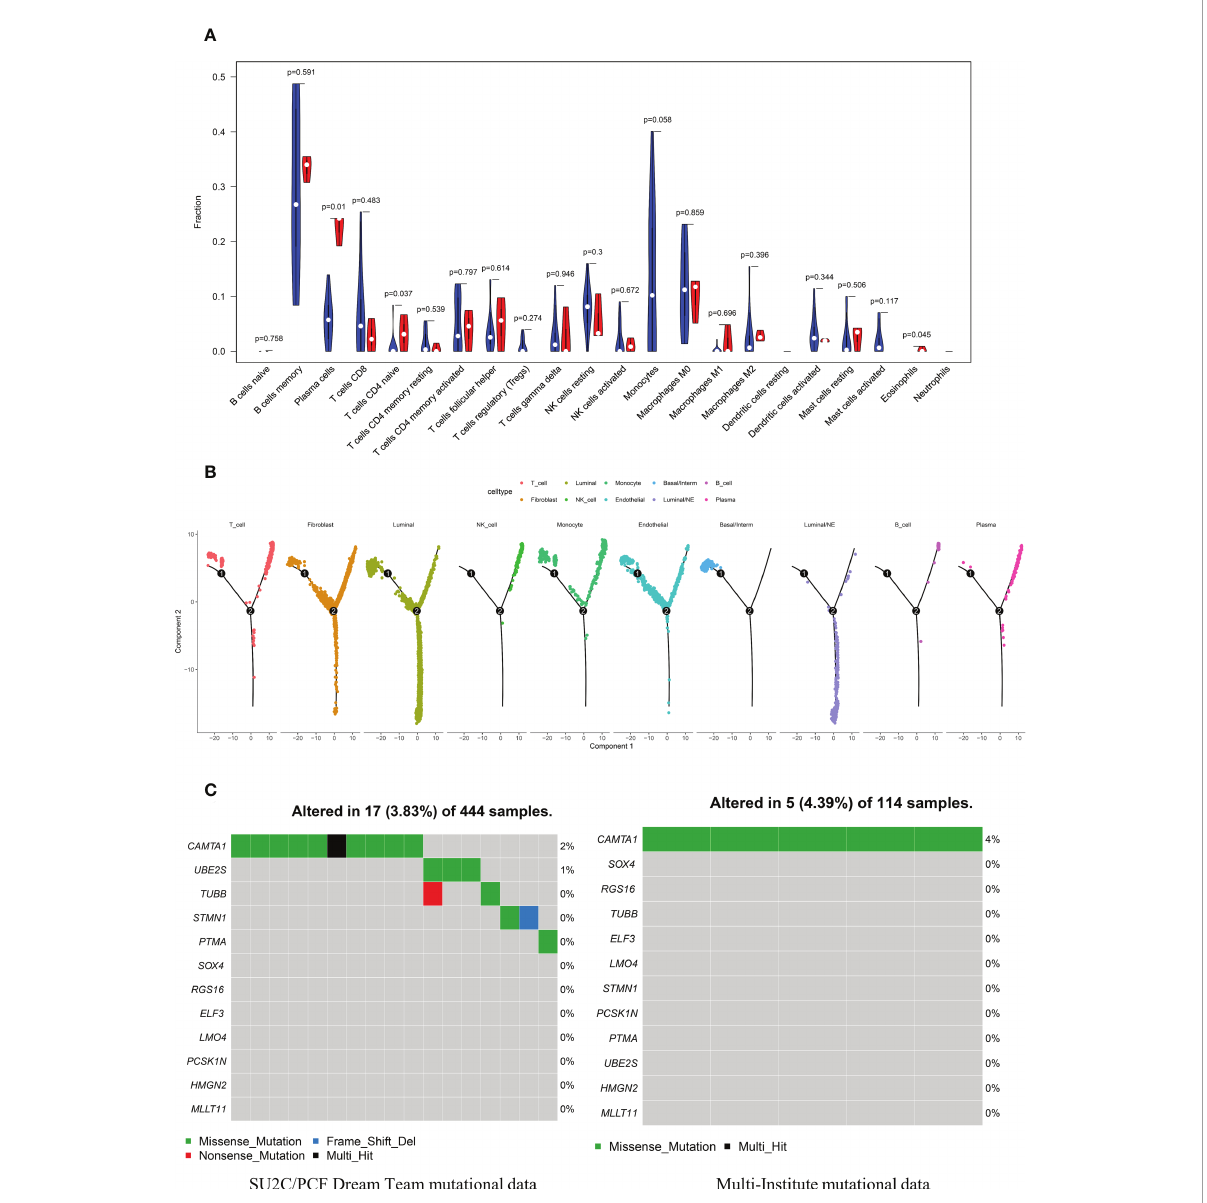
FIGURE 8 The distribution landscape of immune cell, and TMB pattern between CRPC and CRPC-NE (A) The difference of 22 immune in fi ltration between CRPC and CRPC-NE groups, red color indicates the abundance of immune cells in the latter, blue color indicates the abundance in the former. (B) Pseudotime trajectory analysis elucidated luminal/NE cluster and immune cells like NK, T, B and Plasma cells moved towards the termini of the trajectory. (C) Waterfall plots summarize the mutation landscape of 12 CRPC-NE featured genes in CRPC and CRPC-NE samples, showing that the mutation rate of these genes is low except